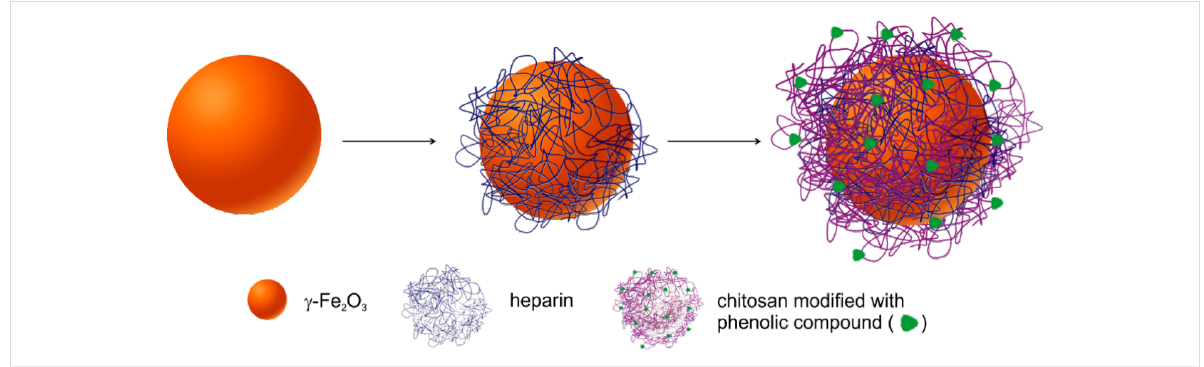
Figure 8: A schematic of the iron oxide nanoparticle coating with heparin and gallic acid-modified chitosan.